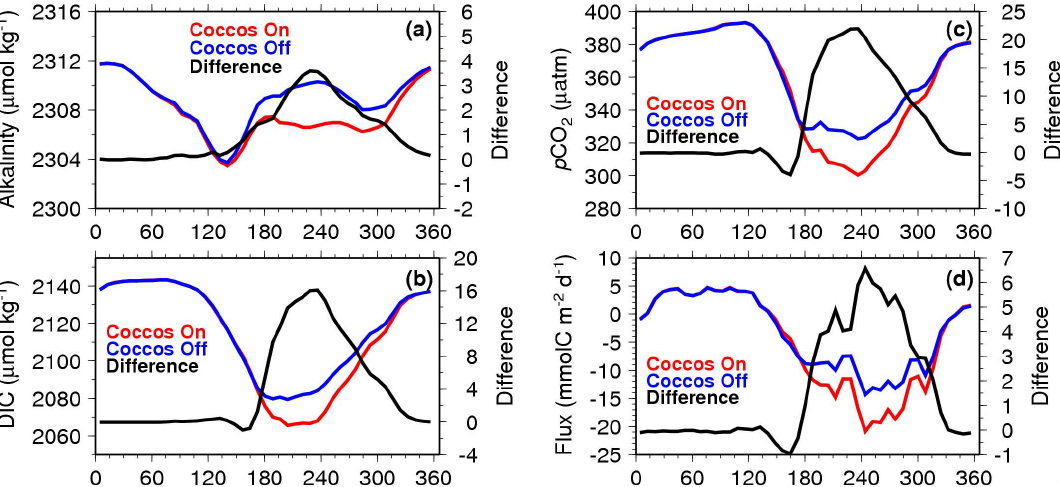
Fig. 14. Seasonal (1998—2008) changes of alkalinity (a) , DIC (b) , surface ocean p CO 2 (c) , and sea-air CO 2 flux (d) with (red) and without (blue) coccolithophores. The black line is the